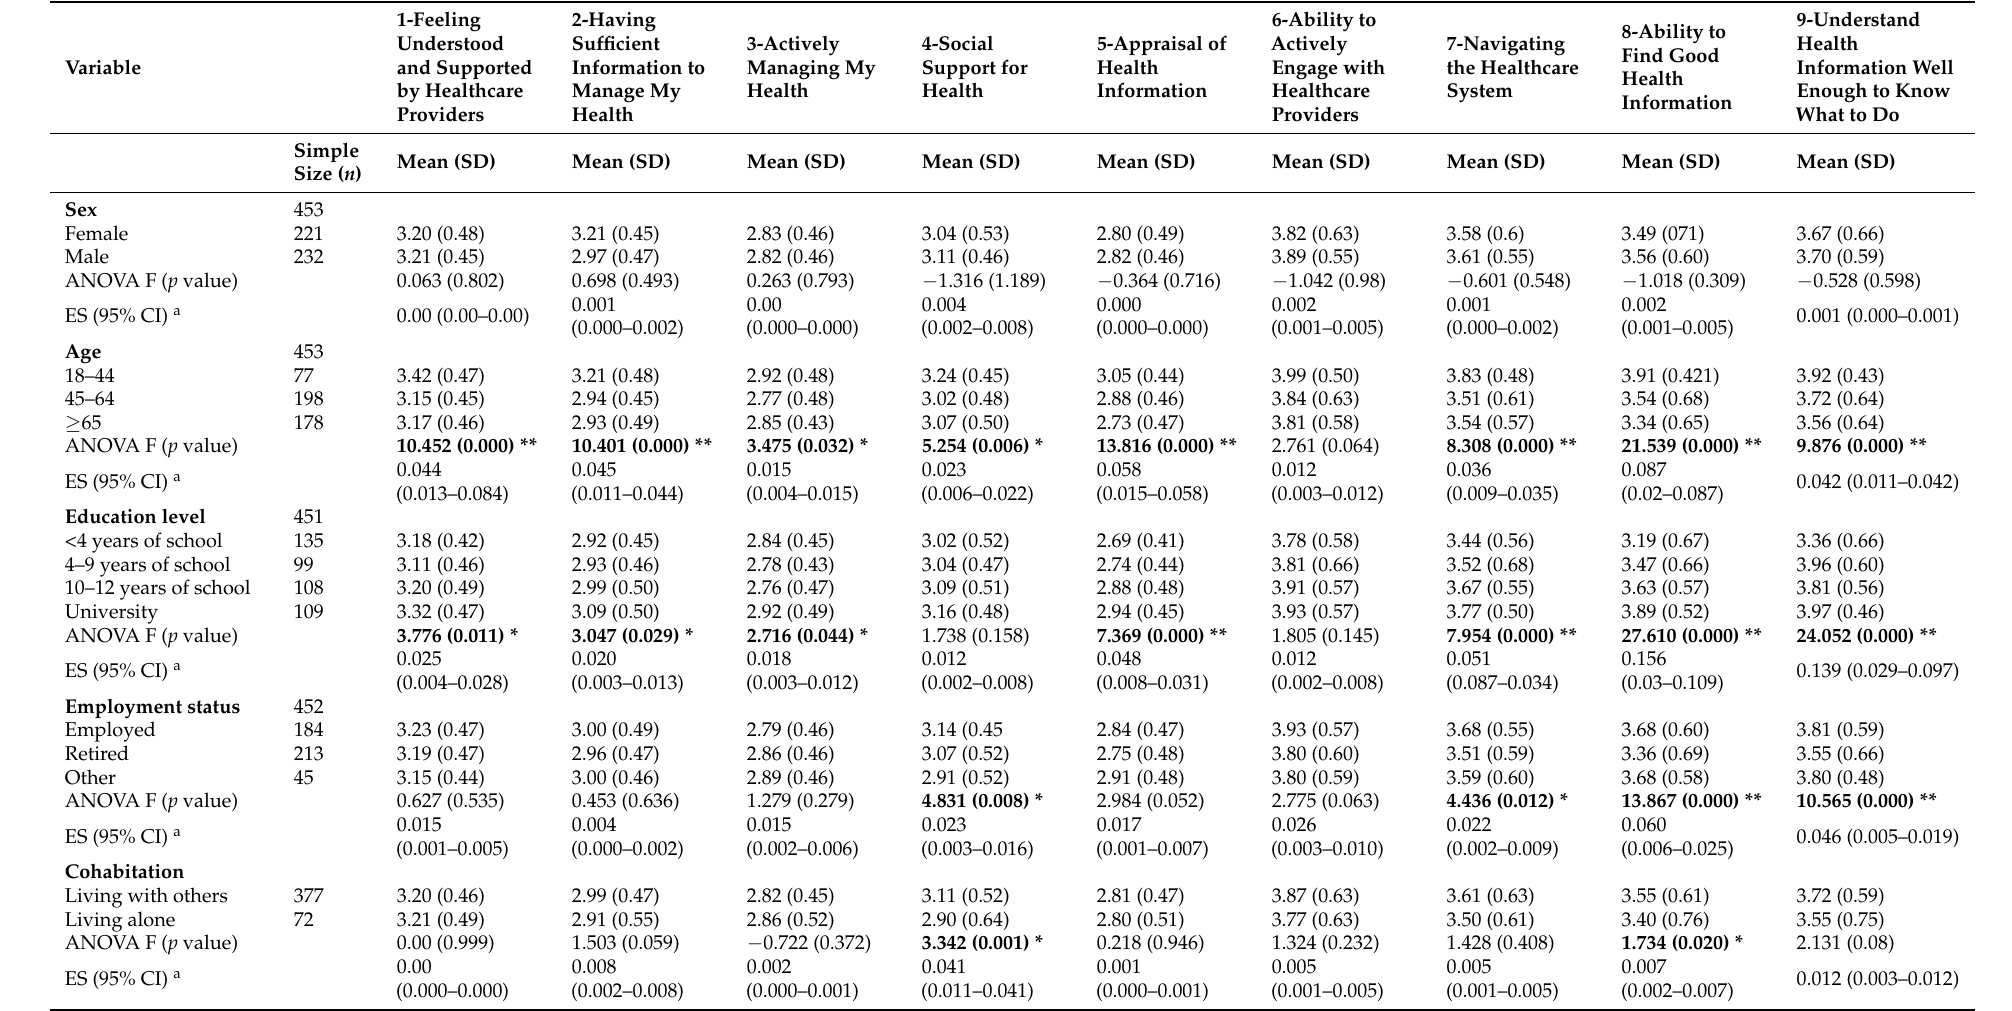
Table 7. Relationship between Health Literacy Questionnaire (HLQ) scales and social, clinical variables and health